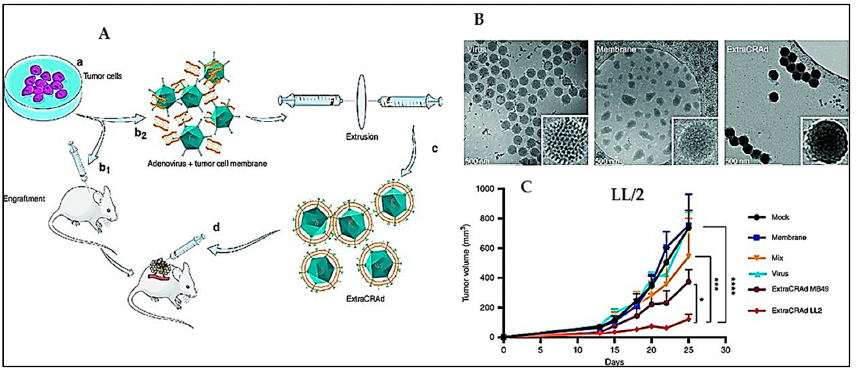
Figure 11. ( A ) Tumour cells (a) were cultured and engrafted into mouse model (b 1 ). (b 2 )The cell membrane was extracted and mixed with an oncolytic adenovirus serotype 5, with a 24-base-pairs deletion, carrying -CpG islands (i.e., A5- Δ 24-CpG). (c) The virus was wrapped with the cell mem brane using the process of extrusion to obtain ExtraCRAd. (d) The established tumours were treated with multiple intratumoral injections of ExtraCRAd. ( B ) Cryo-transmission electron microscopy (TEM) images of virus, lipid cancer membrane vesicles, and ExtraCRAd ( C ) Median tumour growth [138]. The results were analyzed with a two-way ANOVA, and Dunnet’s post-test comparison, and the levels of significance were * p < 0.05, *** p < 0.001, **** p < 0.0001. Copyright CC BY